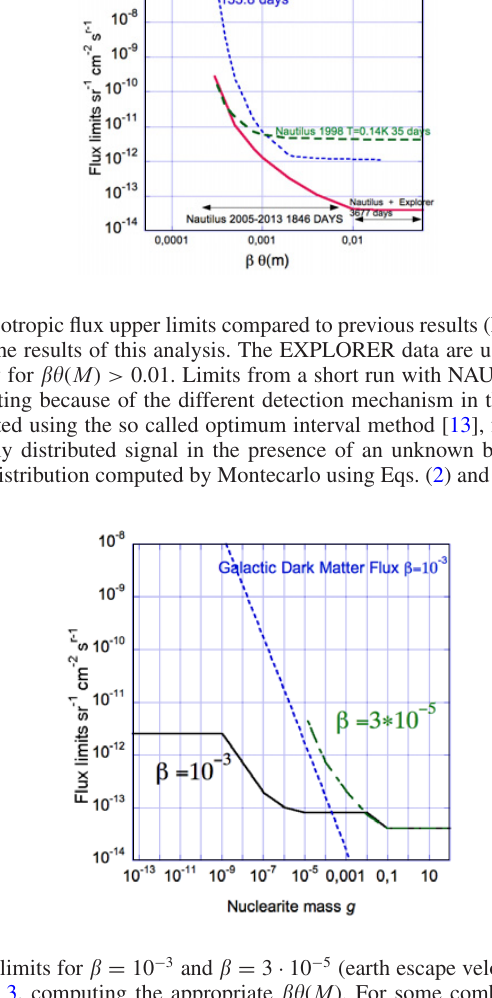
Figure 4. Flux upper limits for (cid:5) = 10 − 3 and (cid:5) = 3 · 10 − 5 (earth escape velocity) vs mass. The limits are derived from Fig. 3, computing the appropriate (cid:5)(cid:4) ( M ). For some combination of masses and (cid:5) nuclearites cannot cross the earth, in this case a factor 2 is applied to the limits of Fig. 3. For mass between 5 · 10 − 14 g (threshold due to the atmosphere) and 10 − 4 g this limit is significantly smaller than the flux of galactic dark matter for (cid:5) = 10 − 3